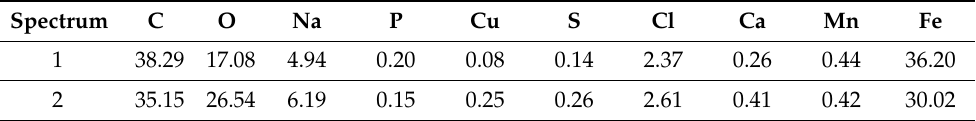
Table 5. EDS results of the corrosion scale formed on L245N standard steel after 4 days of testing, (at. %). The spectrum labels correspond to Figure